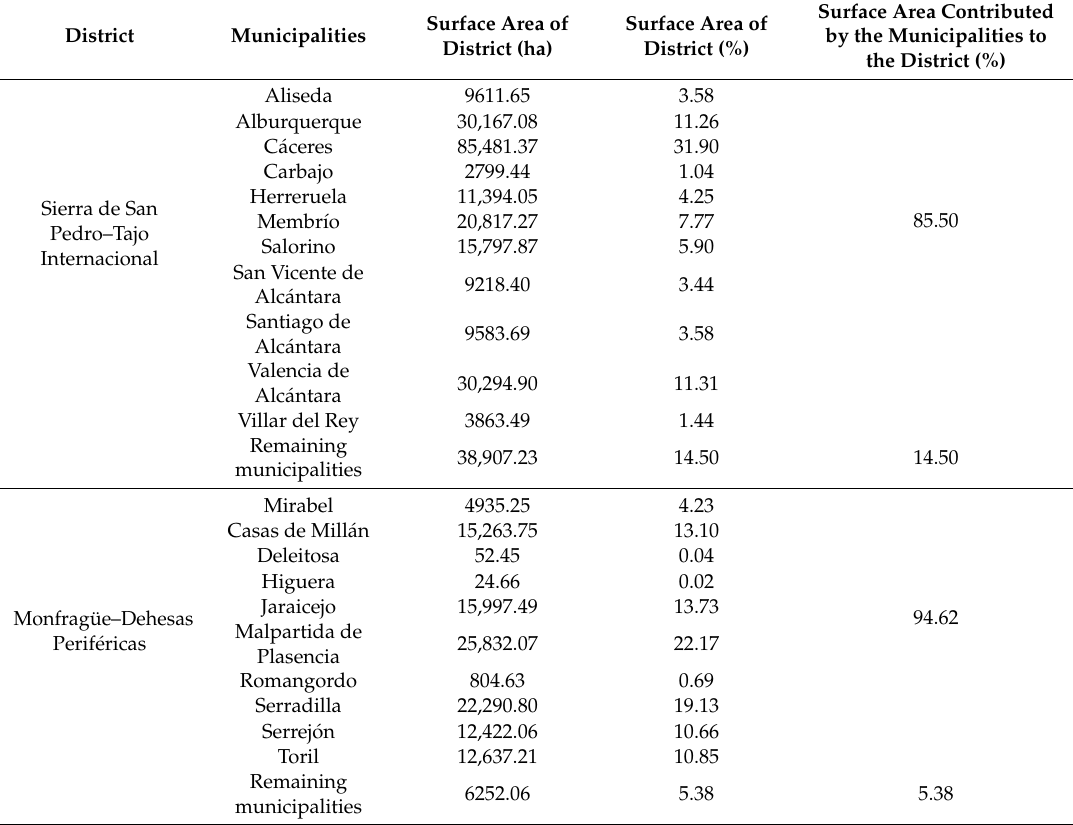
Table 1. Surface area.